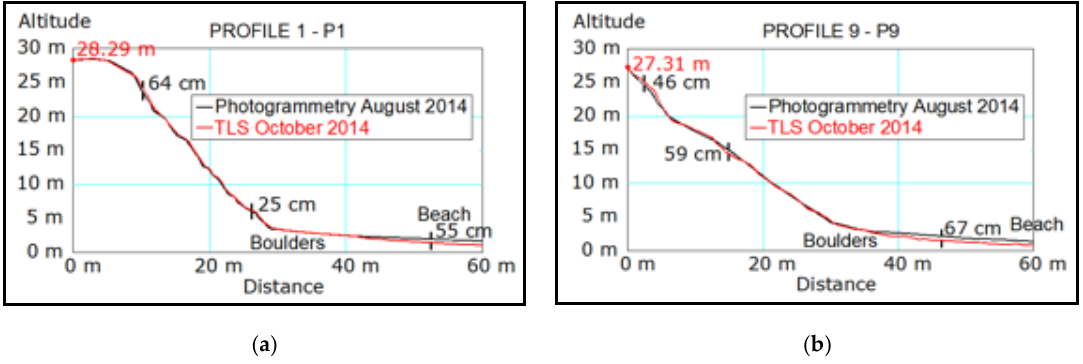
Figure 10. Comparison between the profiles obtained by photogrammetry and by TLS (2014). ( a ) Profile 1 (north area of the cliff); ( b ) Profile 9 (south area of the cliff).